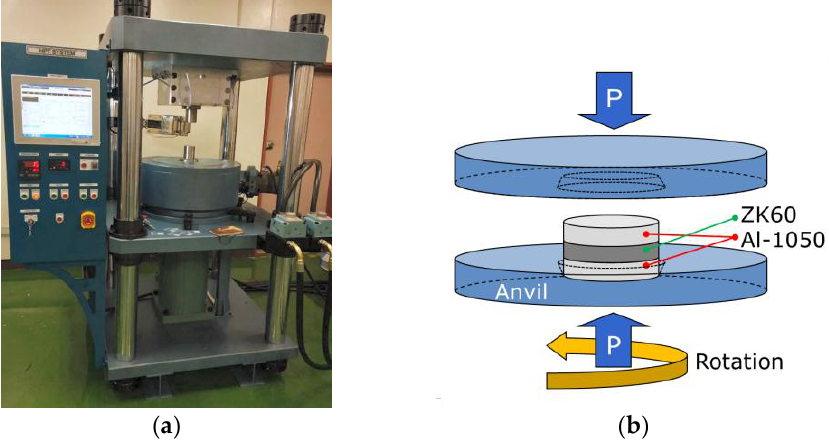
Figure 9. ( a ) Photograph of the HPT facility and ( b ) schematic illustration of the sample set-up for HPT processing